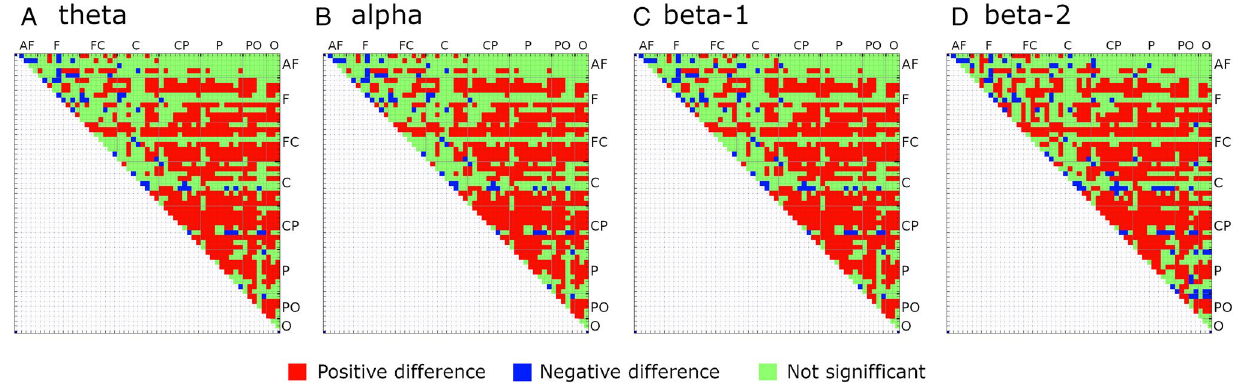
Figure 3. PLV differences between Pandemic and Pre-pandemic Control groups in Session-1. Green squares denote a lack of significance. Differences significant at p < 0.01, Bonferroni corrected. Abbreviation for regions with appropriate electrodes: AF – anterofrontal; F – frontal; C – central; CP – centroparietal; P – parietal; PO – posterooccipital; O – occipital. Created using MATLAB 2020a (The MathWorks, Inc, www. mathw orks.